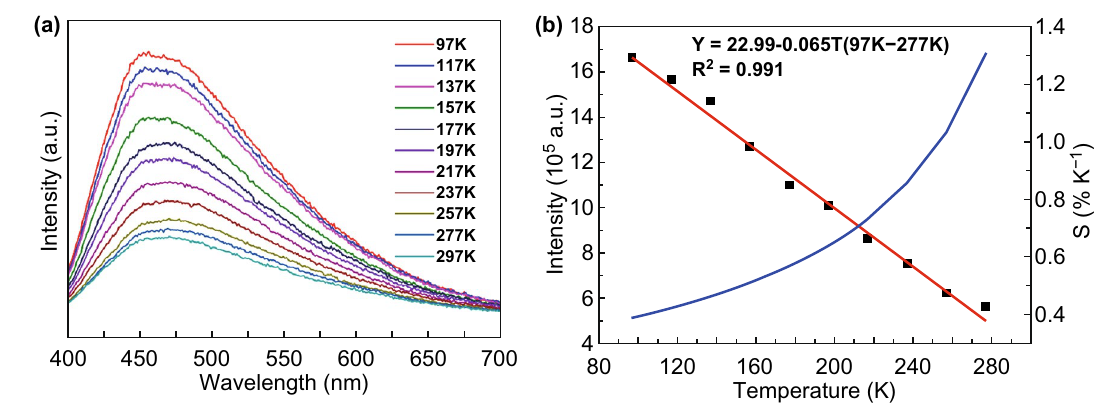
Fig. 26 a PL emission spectra of C-QDs@UiO-66-(COOH) 2 film in the temperature range of 97–297 K. b Emission intensity of the C-QDs@ UiO-66-(COOH) 2 film as a function of temperature (black squares, left axis) with the fitting curve (red line, R 2 = 0.991) and the relative sensitiv- ity curve (blue line, right axis). Reprinted with permission from Ref. [46]. Copyright 2018, American Chemical Society